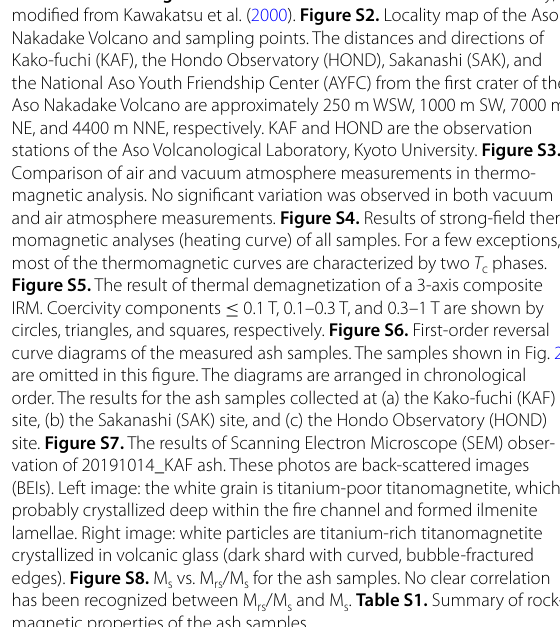
(BEIs). Left image: the white grain is titanium-poor titanomagnetite, which probably crystallized deep within the fire channel and formed ilmenite lamellae. Right image: white particles are titanium-rich titanomagnetite crystallized in volcanic glass (dark shard with curved, bubble-fractured edges). Figure S8. M s vs. M rs /M s for the ash samples. No clear correlation has been recognized between M rs /M s and M s . Table S1. Summary of rock- magnetic properties of the ash